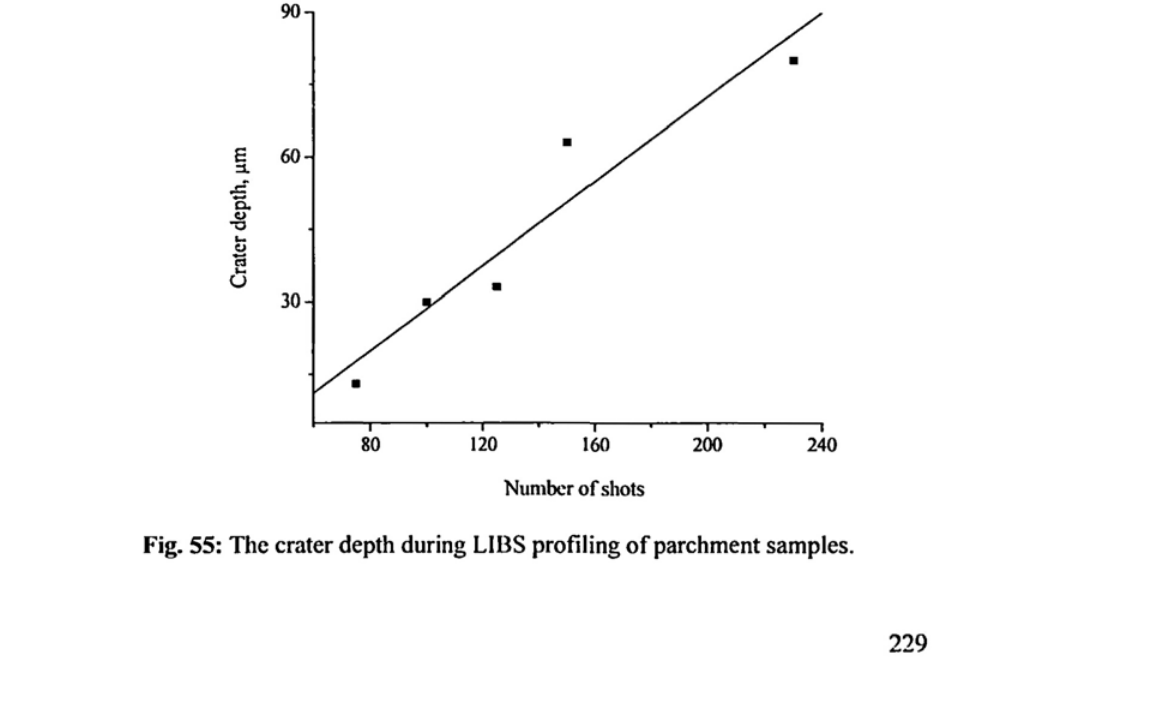
Fig. 54: Crater obtained in parchment samples during depth profiling LIBS measurements.